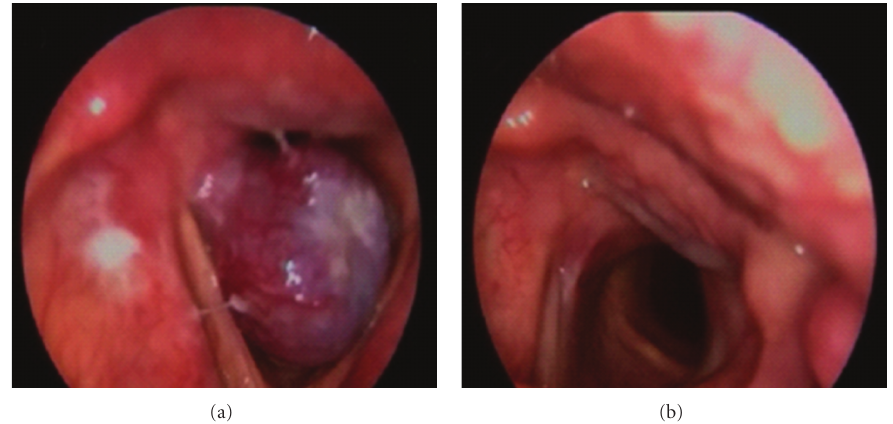
Figure 1: (a) Preoperative Videolarygoscopy. A smooth submucosal tumor located in the left arytenoid. (b) Videolaryngoscopic appearance at the 4 postoperative week.